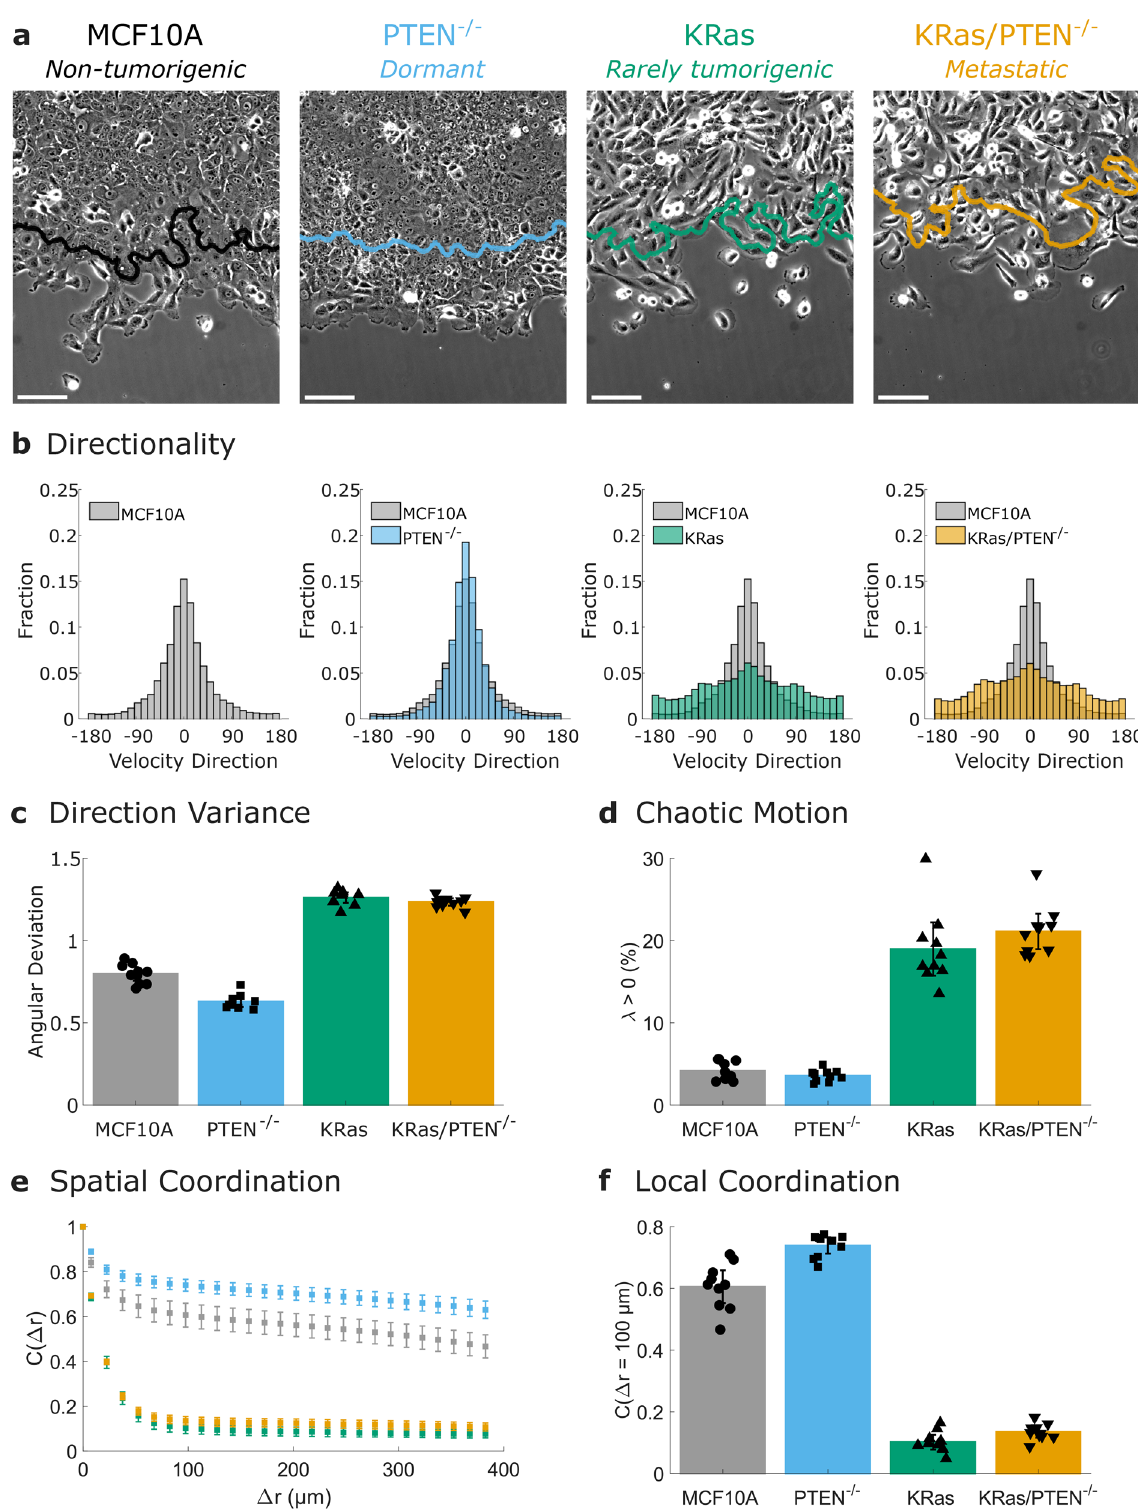
Figure 3. Activated KRas and PTEN −/− have opposing effects on collective migration. ( a ) Images from collective migration assays on cells from a genetically defined cancer model system after 12 h of migration. The position of the initial (t = 0 h) leading edge is indicated by the colored line and scale bars are 100 µm. See also Supplementary Video S2. ( b ) Cumulative distributions of velocity direction. ( c ) Variability in velocity direction quantified by angular deviation. ( d ) Chaotic motion in the cell sheet quantified by the percentage of positive finite-time Lyapunov exponents (λ). ( e ) Spatial coordination across length scales quantified by the autocorrelation of radial velocity. ( f ) Local coordination is defined as the correlation value at 100 µm (a few cell lengths). N = 10 independent experiments. Error bars indicate 95% confidence